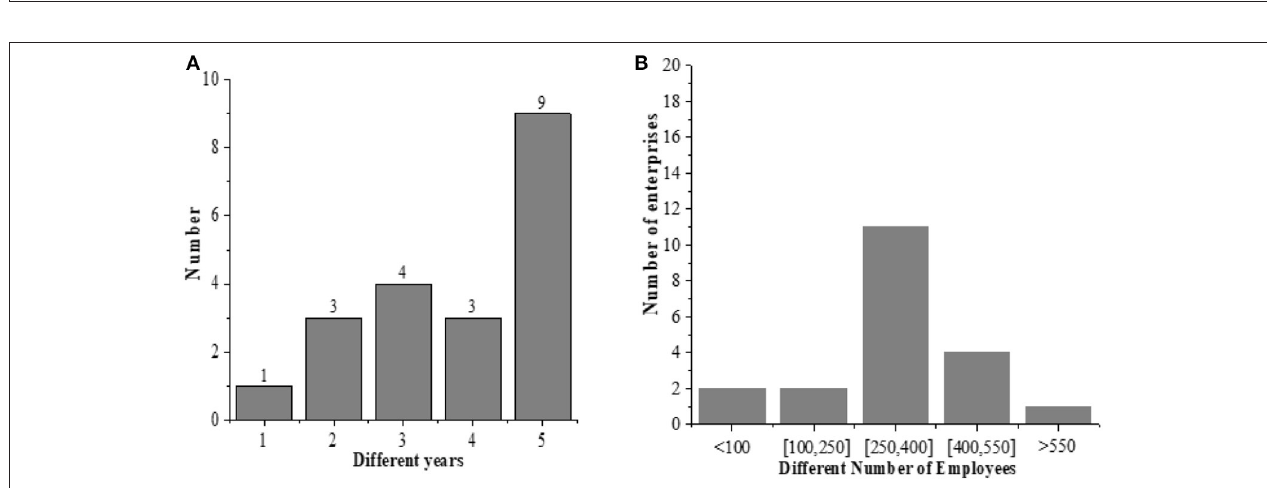
FIGURE 4 | The establishment time and the number of the employees ( A : the establishment time; B : the number of employees).